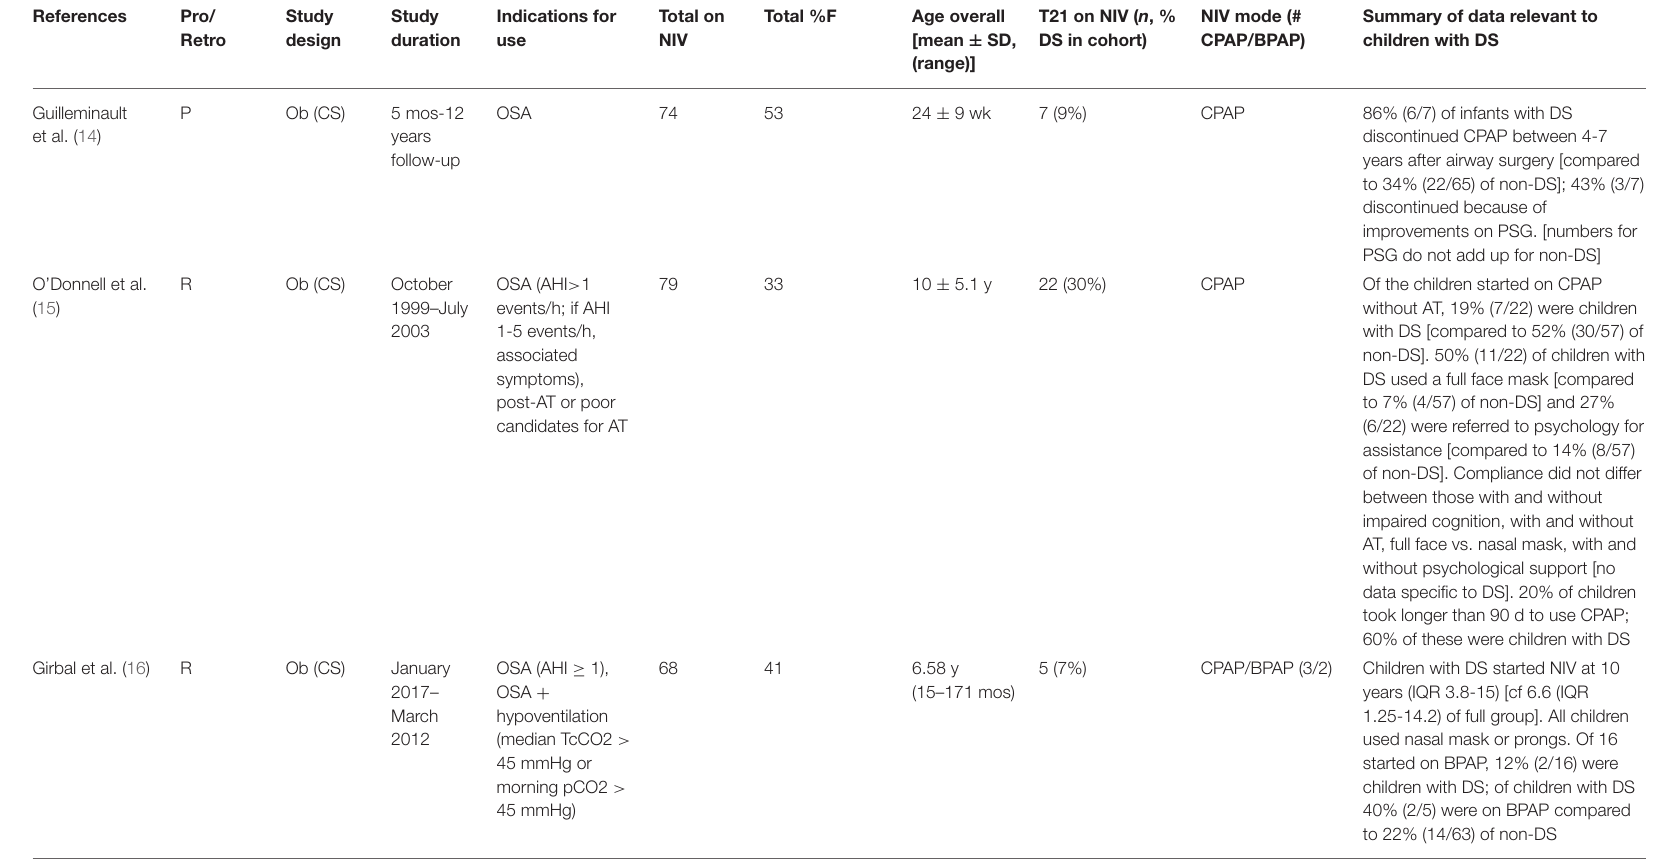
TABLE 1 | Summary of studies including data on children with Down syndrome within a larger group of children using long-term non-invasive